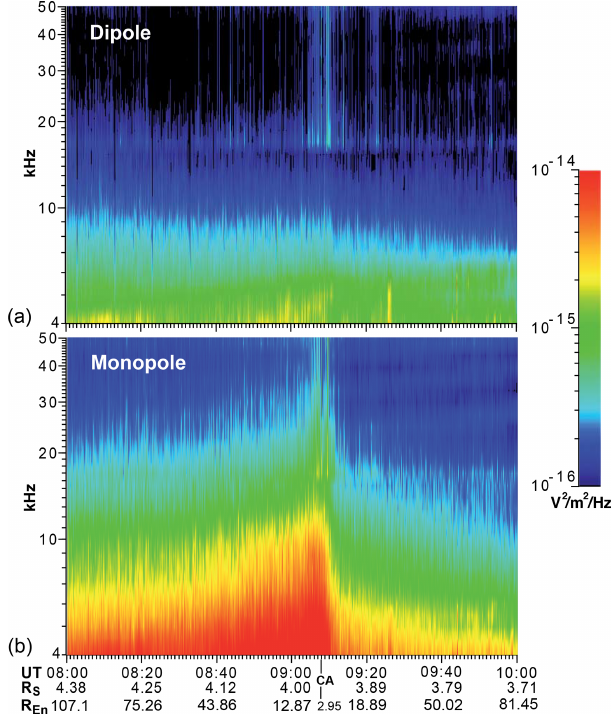
Figure 7. From Meyer-Vernet et al. (2014): time-frequency electric power spectral density measured by Cassini/RPWS on 9 March 2005 in Saturn’s E ring, in dipole (a) and monopole mode (b) . The increase due to micron-sized dust impacts on the spacecraft only appears in monopole mode, whereas the dipole only measures the weaker plasma quasi-thermal and impact